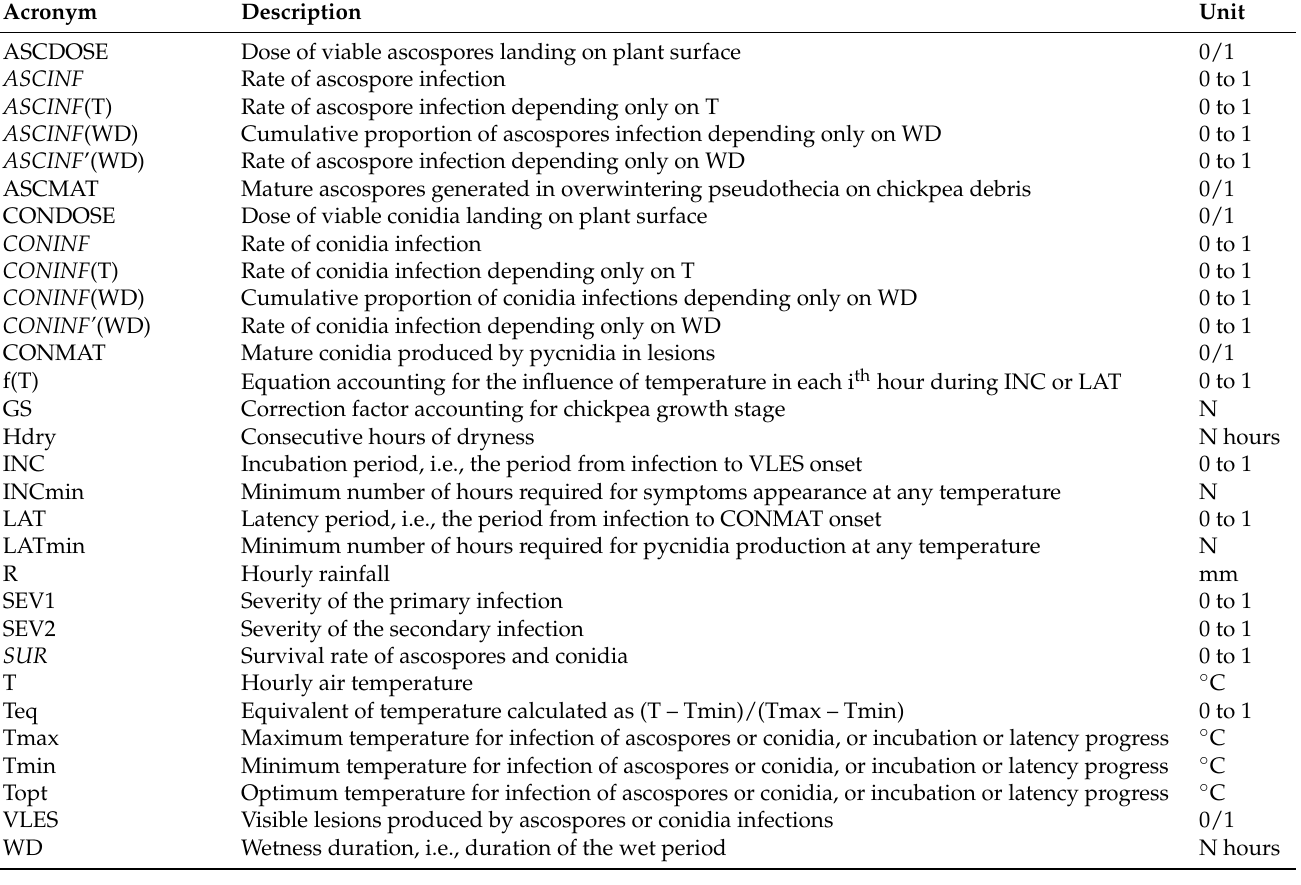
Table 1. List of variables, rates, and parameters used in the model, and their